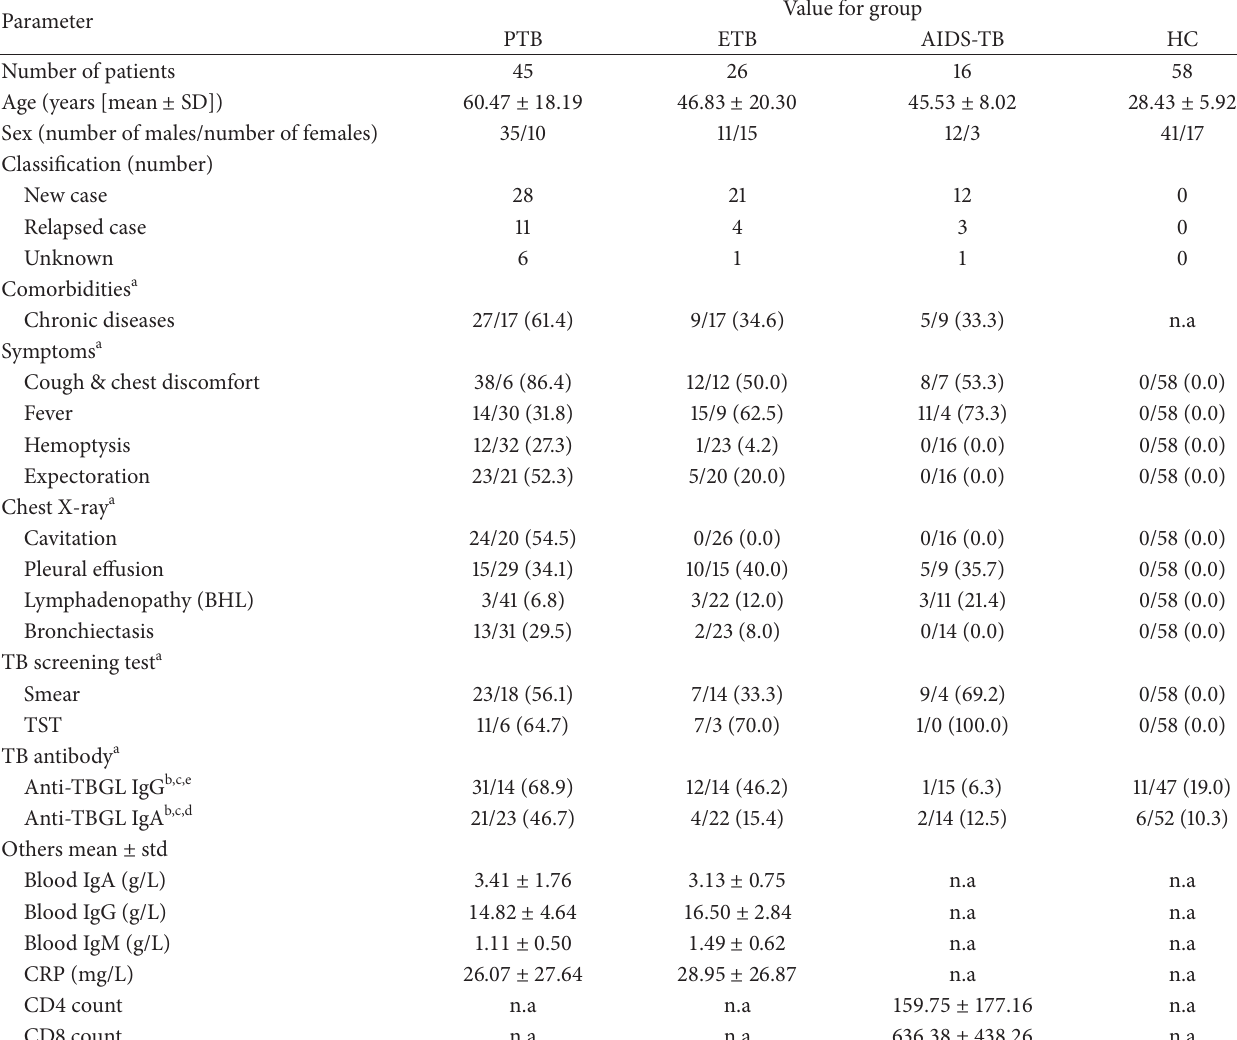
Table 1: Clinical and demographic information of study patients.